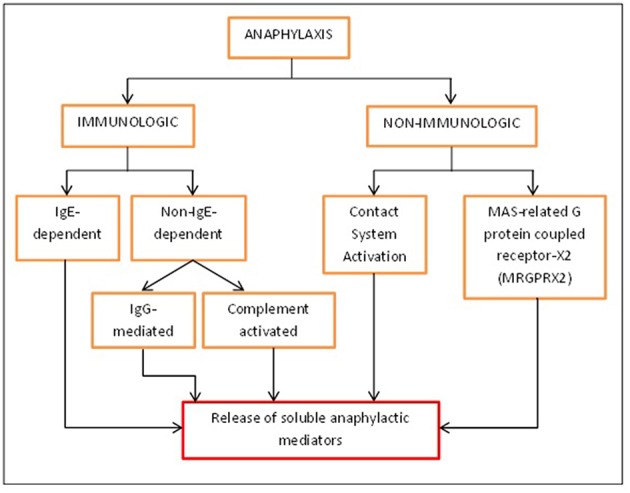
Different activation pathways of anaphylaxis. Anaphylaxis can be activated immunologically and non-immunologically. Immunologically, anaphylaxis can be either IgE-dependent or non-IgE-dependent while non-immunologically; it can be caused by contact system activation or MRGPRX2 found on mast cells. All of these will eventually lead to the release of soluble mediators that will bring about the symptoms of anaphylaxis.